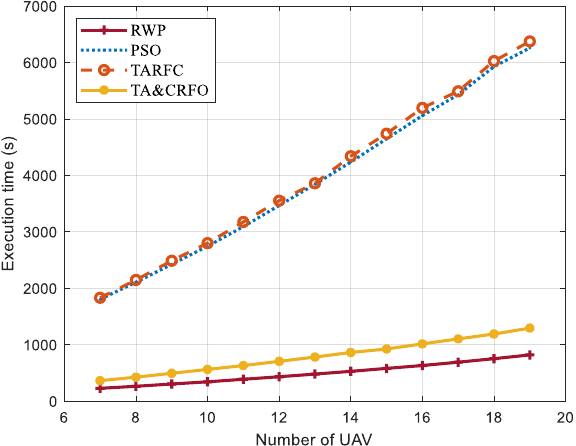
Figure 14. The average execution time of different algorithms.